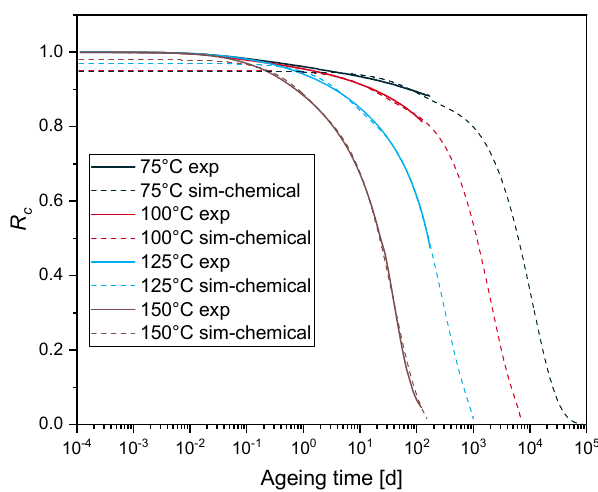
( b ) Figure 6. ( a ) CS after tempering versus ageing time for EPDM at different temperatures, ( b ) Initiation times at different temperatures. The initiation time values of EPDM aged at 150 °C, 125 °C, 100 °C and 75 °C are collected in Table 1. It was expected that the initiation time of EPDM aged at 75 °C would be higher than that determined in Table 1 as, normally, the initiation time increases with decreasing temperatures. This is probably due to the lower values of CS after tempering. Even for samples aged at 75 °C for five years, CS did not exceed 14% [36]. Table 1. Initiation time at the four ageing temperatures for EPDM. 150 °C 0.19 Figure 7 presents the normalized continuous stress relaxation (cid:1844) (cid:1855) with two first order chemical relaxation processes. Three first order chemical relaxation processes were also tested (not presented